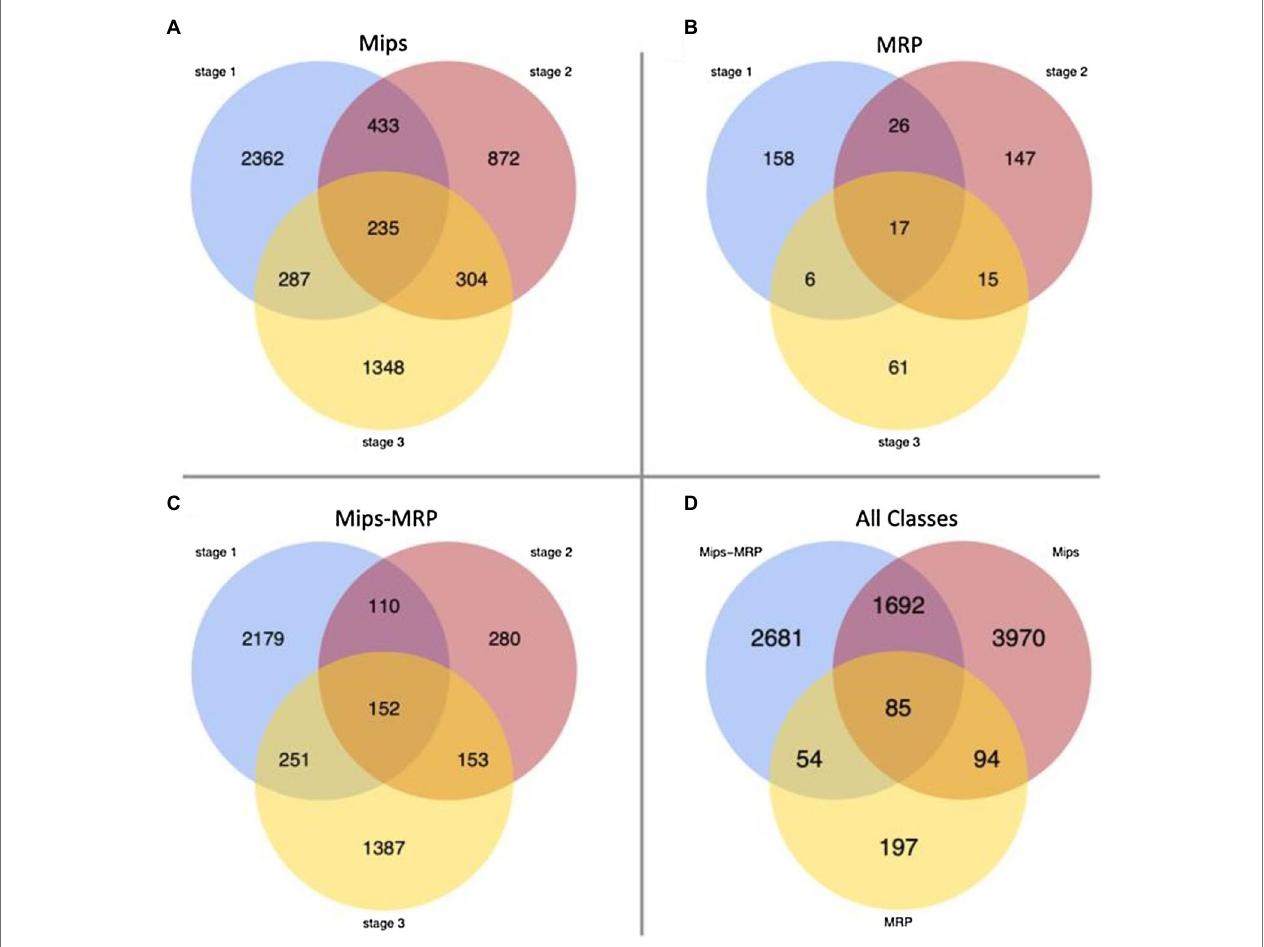
FIGURE 1 | Venn diagrams of differentially expressed genes (DEGs). (A) Number of DEGs unique to and shared between each stage in the monophosphate synthase (Mips) subset. (B) Number of DEGs unique to and shared between each stage in the multidrug resistance-associated protein (MRP) subset. (C) DEGs in the Mips-MRP subset. (D) Number of DEGs unique to and shared between all three subsets of